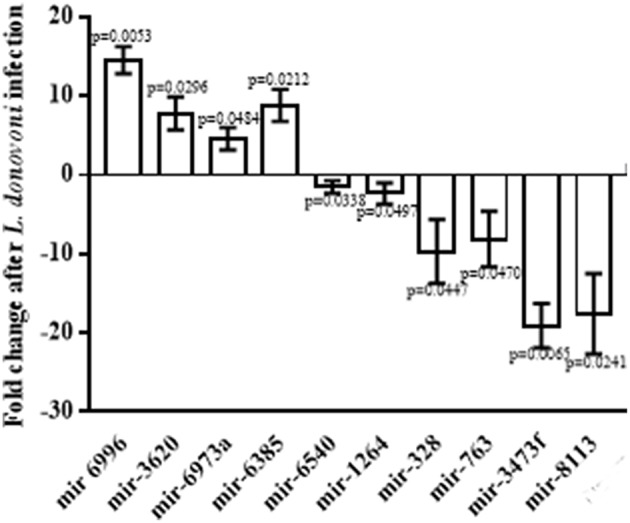
Relative expression of miRNAs in infected macrophages. Macrophages were infected with L. donovani in a ratio of 1:10 (macrophage: parasite) for 6 h, and then thoroughly washed to remove non-ingested parasites. Macrophages were further incubated at 37°C for 24 h and total RNA was isolated from lysed cells. The miRNAs, mir-6996, mir-3620, mir-6973a, and mir-6385 were found significantly up regulated whereas mir-6540, mir-1264, mir-328, mir-763, mir-3473f, and mir-8113 were found significantly down regulated.